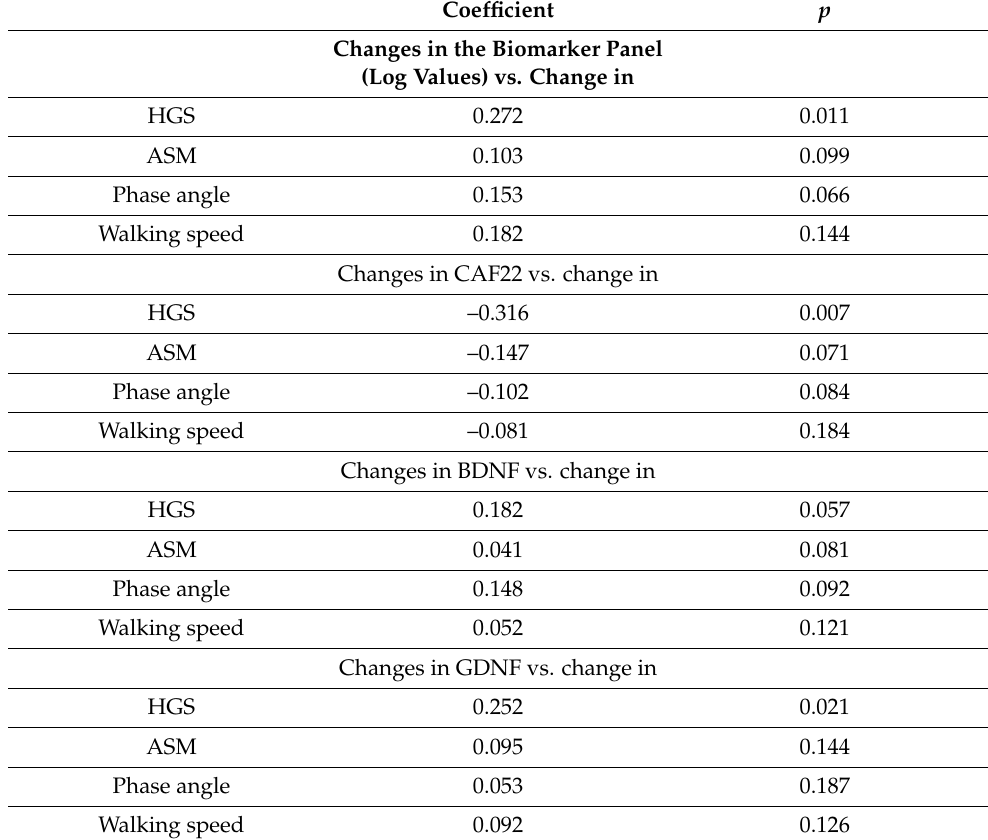
Table 3. Multiple regression analysis investigating the associations of changes in biomarkers levels with changes in handgrip strength (HGS), appendicular skeletal mass (ASM), phase angle, and walking speed in patients with COPD during pulmonary rehabilitation ( n =